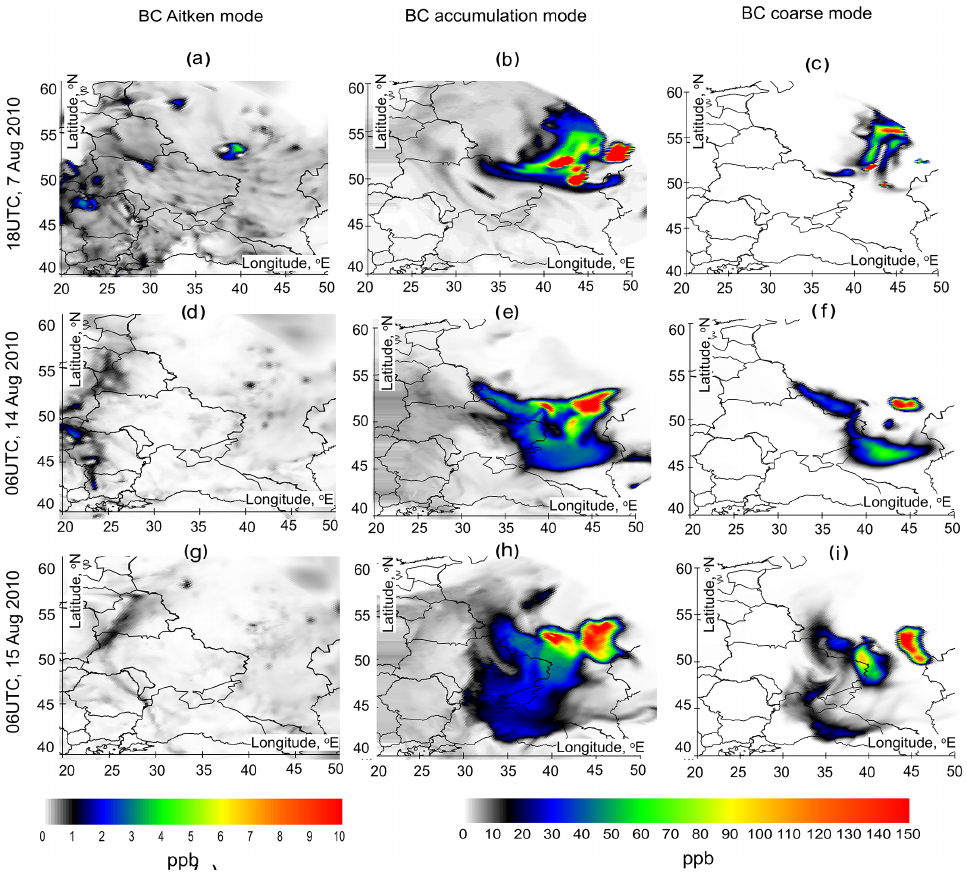
Figure 2. The spatial distribution of the BC for the Aitken (a, d, g) , accumulation (b, e, h) , and coarse (c, f, i) modes in the days of air movement towards Ukraine, with the highest BC content near the